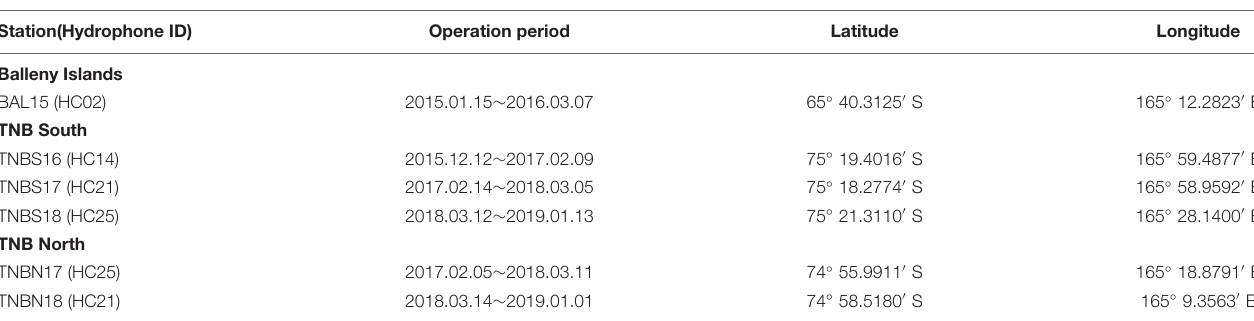
FIGURE 1 | (A) Location map of hydrophone mooring in the Balleny Islands (BI) region during January 2015 to March 2016. (B) Location map of north and south moorings in Terra Nova Bay (TNB) polynya during December 2015 to January 2019 in the Western Ross Sea, Antarctica. Inset map (C) shows the geographic locations of the BAL15 station (blue triangle), sea-ice concentration averaging area (50 km radius circle with blue shade), and Balleny Islands. The other inset [ D ; on top of bed topography map (Morlighem et al., 2020)] shows locations of the TNBS16-18 and TNBN17-18 (red triangles), sea ice concentration averaging area (box of 75.5–74.7 ◦ S latitude and 164–166.5 ◦ E longitude with blue shade), Jang Bogo Station (yellow triangle), grounding line (magenta solid line), and coastline (black solid line). TABLE 1 | Properties of the hydroacoustic records in the BI region and